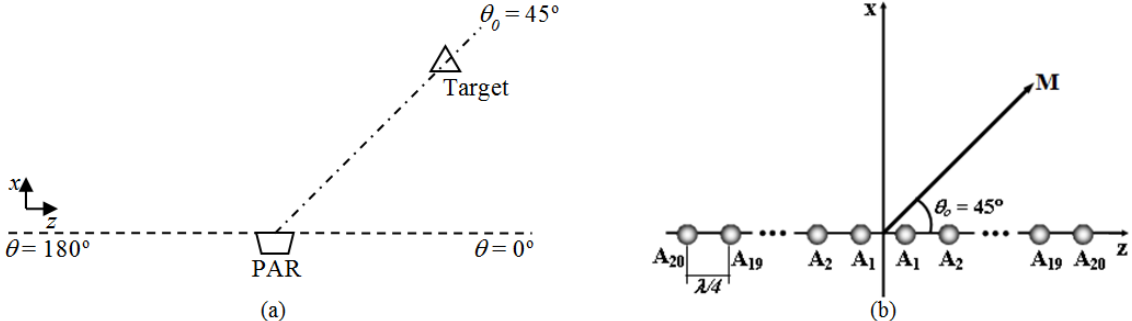
= 45°. ( b ) PA used in the first application of 0 = 45° 0